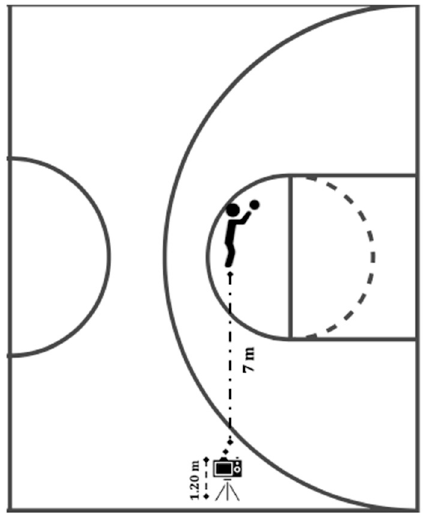
Figure 1. Schematic representation of data collection.